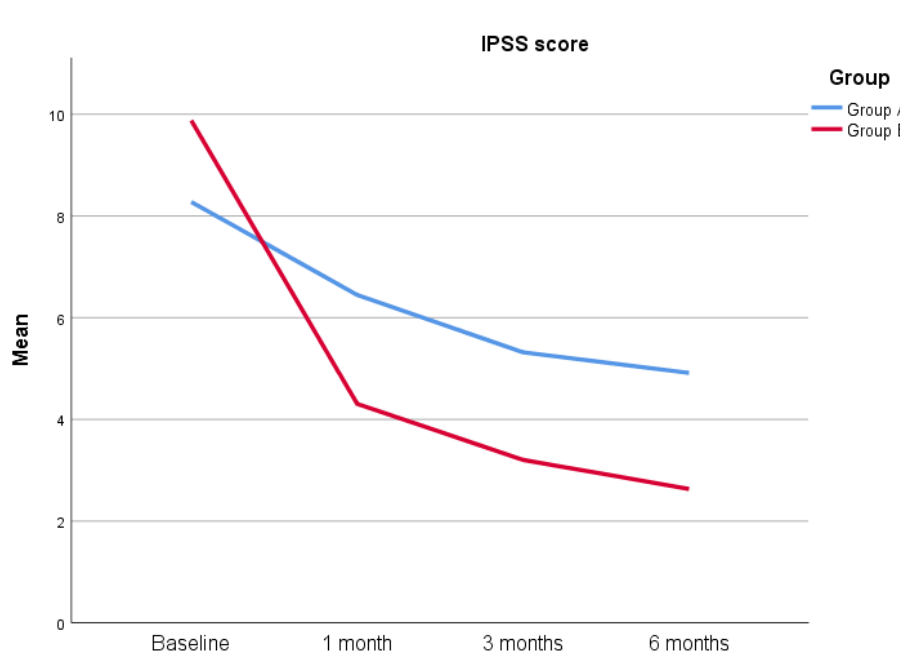
Figure 1. IPSS score from baseline to 6 months after treatment.